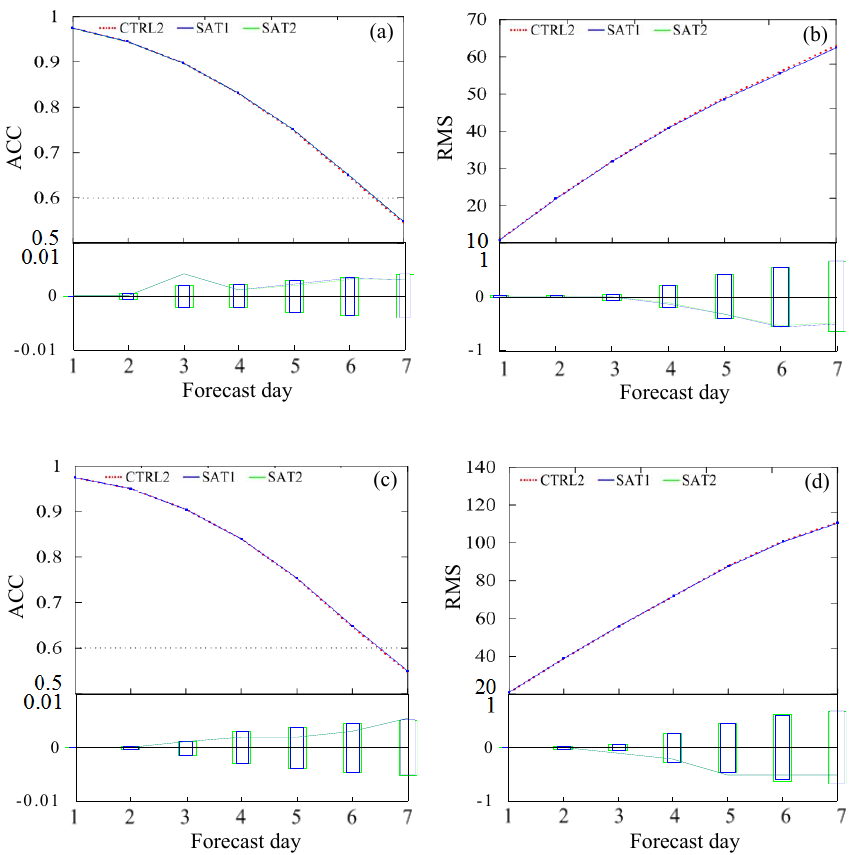
Figure 19. Mean ACC (left panels) and RMS (right panels) of 500hPa geopotential height of CTRL2 (red dashed line), SAT1 (blue solid line), and SAT2 (green solid line) experiments in (a–b) the Northern Hemisphere and (c–d) the Southern Hemisphere for the period from 1 to 27 July 2014. The statistical significance testing of SAT1 and CTRL2 (SAT2 and CTRL2) are shown in the lower part of each figure in blue (green). The ACC and RMS differences outside of outline bars are significant at the 95% confidence